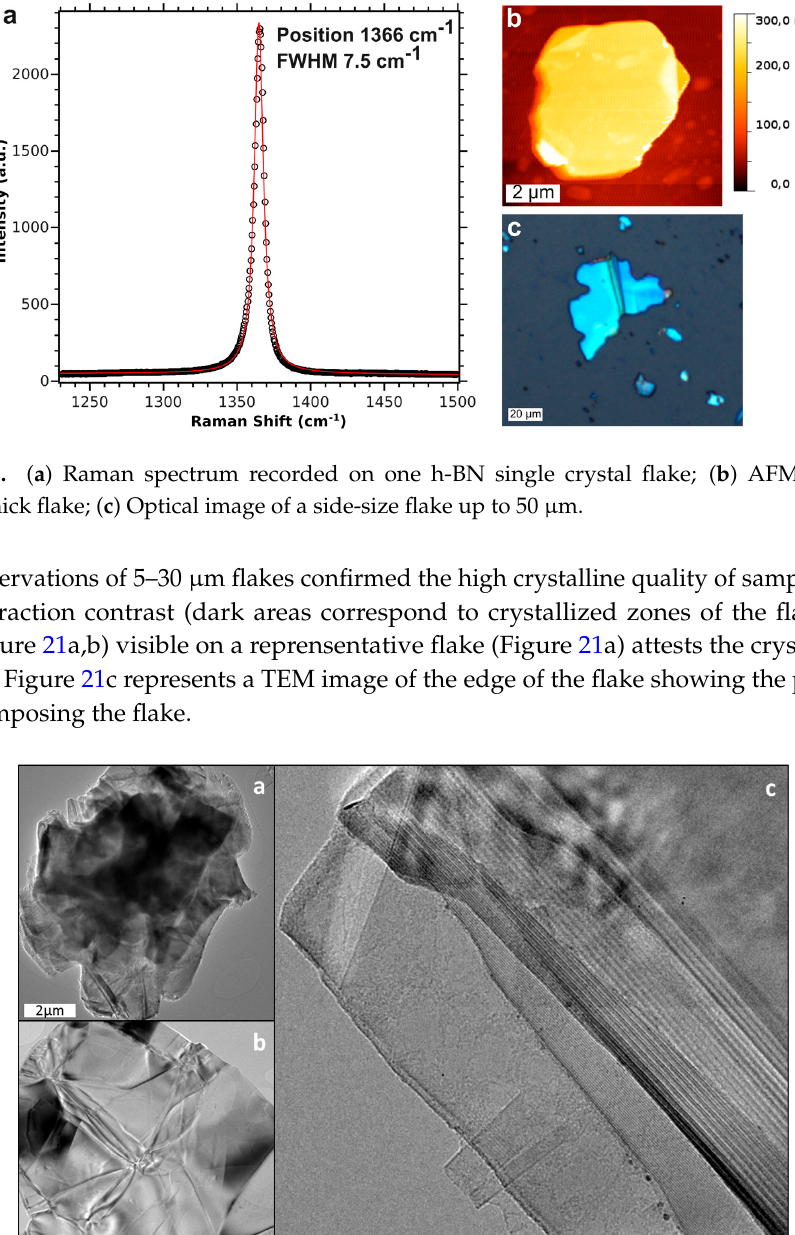
Figure 21. TEM observations performed on 5–30 µm flakes: ( a ) and ( b ) BF-TEM images showing diffraction contrast ; ( c ) TEM image of the edge of the flake proving the staking of BNNSs composing the flake.